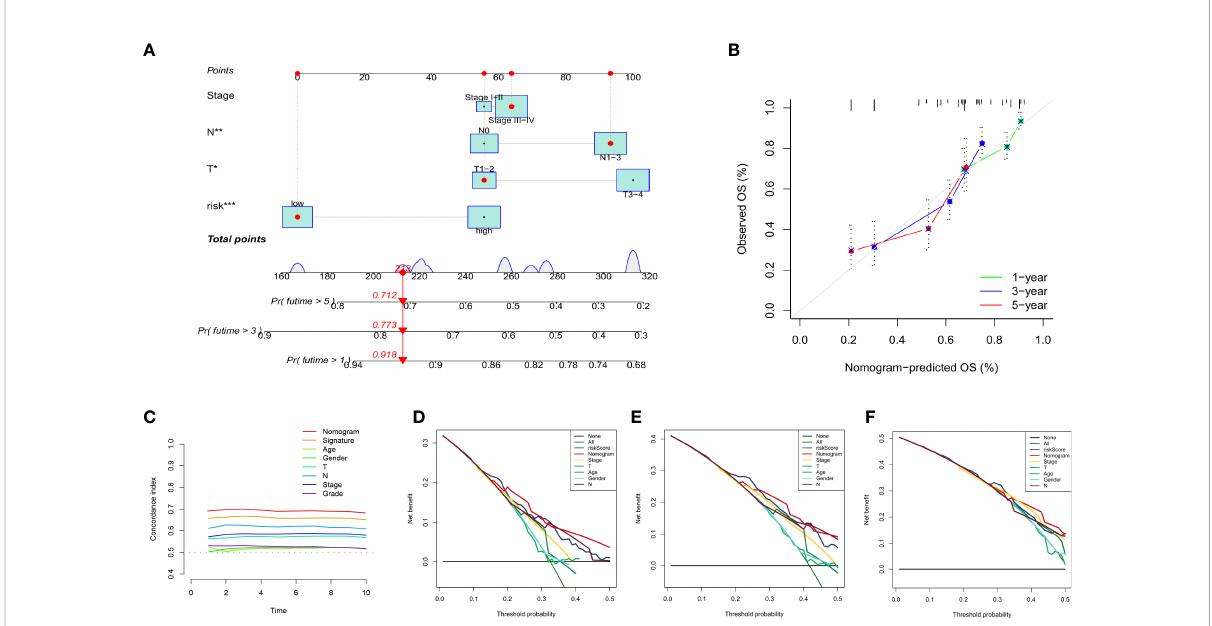
FIGURE 8 Establishment and evaluation of nomogram model in the TCGA dataset. (A) The nomogram for predicting the OS of patients at 1, 3, and 5 years. (B) Calibration curves of the nomogram for 1, 3, and 5 years. (C) The concordance index of the nomogram and other common clinical factors, the nomogram, and the signature showed superiority. Decision curve analysis at 1 (D) , 3 (E) , and 5 (F) years. The X-axis shows different